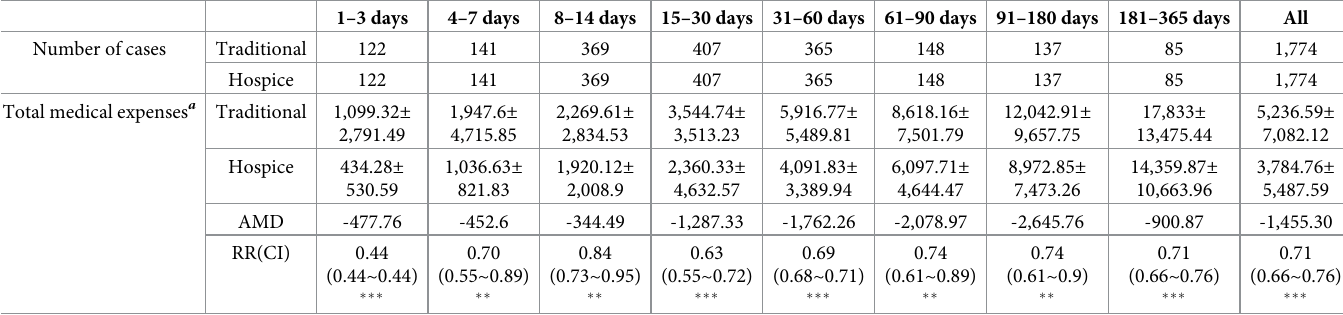
Table 4. Differences in medical expenses between traditional care and hospice care patients a .